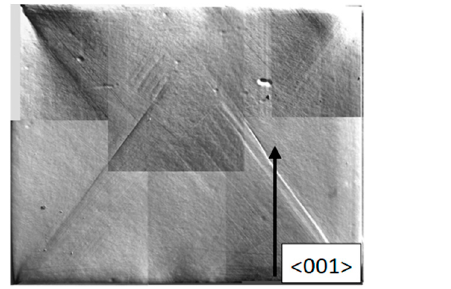
Figure 8. Surface deformation patterns on mutually perpendicular {110} lateral faces of a Ni single crystal. Compression was carried out along the < 001 > axis; h / d = 1, ε = 18%.